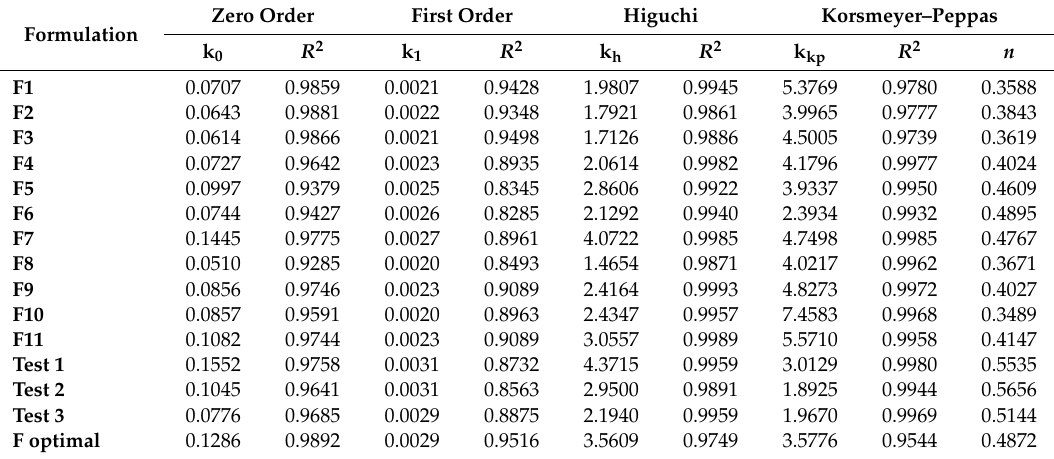
Table 5. Parameters obtained by fitting dissolution data to various mathematical models.